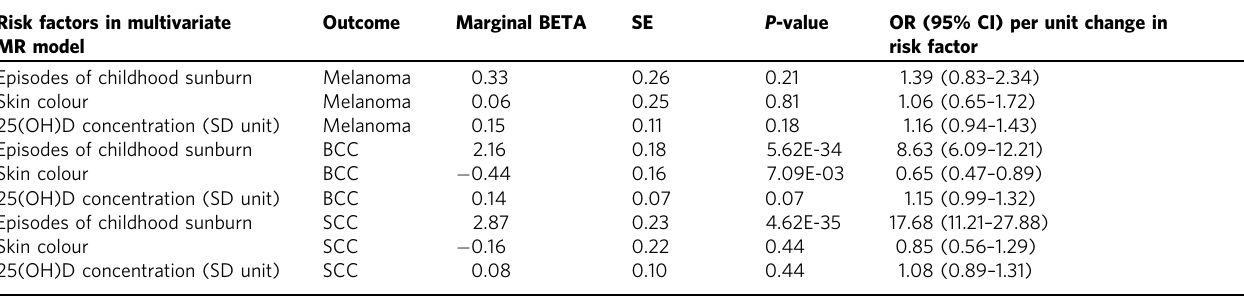
Table 4 Multivariable MR model on skin-related cancers adjusting for episodes of childhood sunburn and pigmentation. Risk factors in multivariate MR